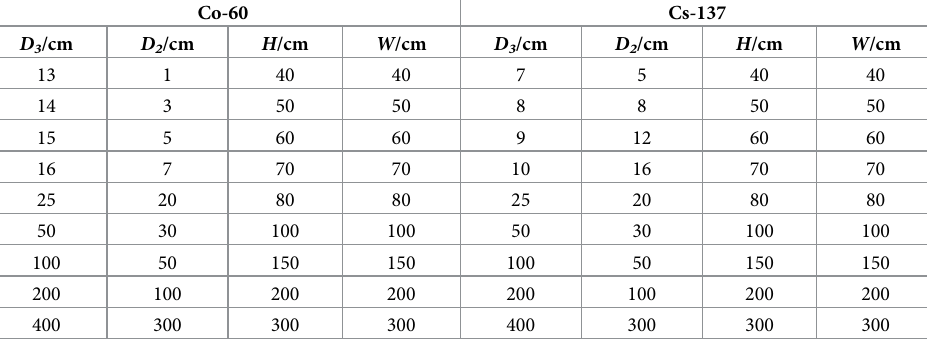
Table 1. The values of input vector in the case of different radioactive sources. Co-60